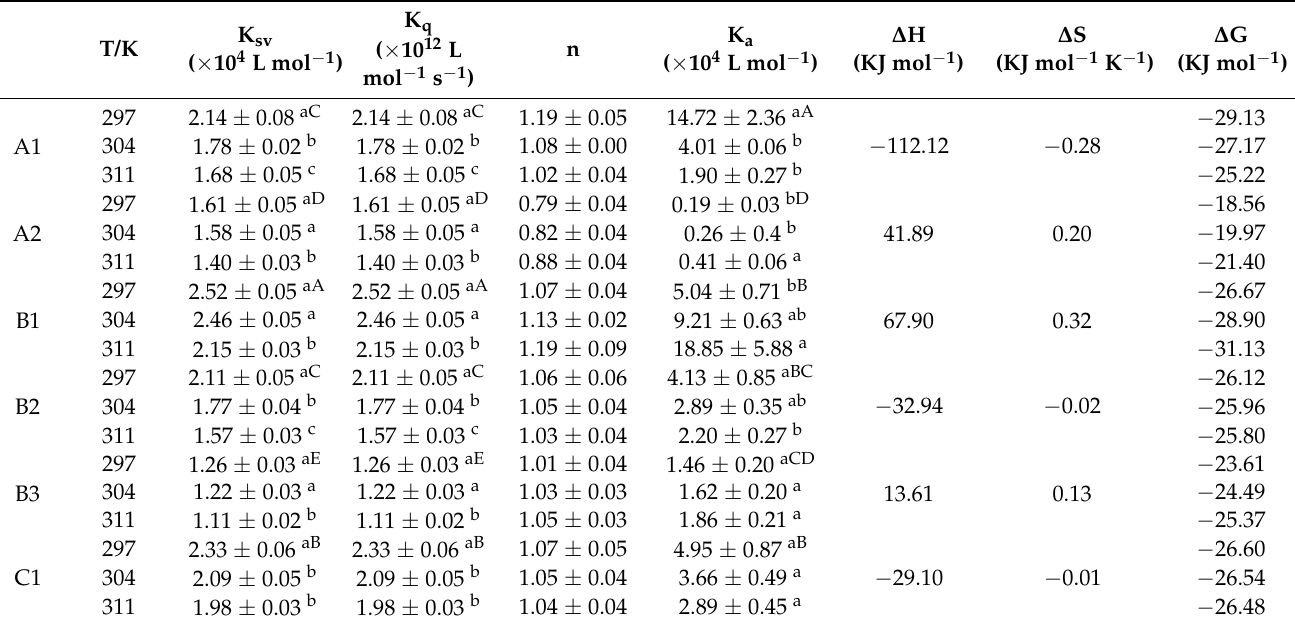
Different lowercase letters indicate that there are significant differences in the same group of proanthocyanidins at different temperatures, p < 0.05. Different uppercase letters indicate that there are significant differences in the different groups of proanthocyanidins at 297 K, p < 0.05. Table 2. Quenching constants, binding constants, and thermodynamic parameters for proanthocyanidins A1, A2, B1, B2, B3, and C1 binding to α -LA at 297, 304, and 311